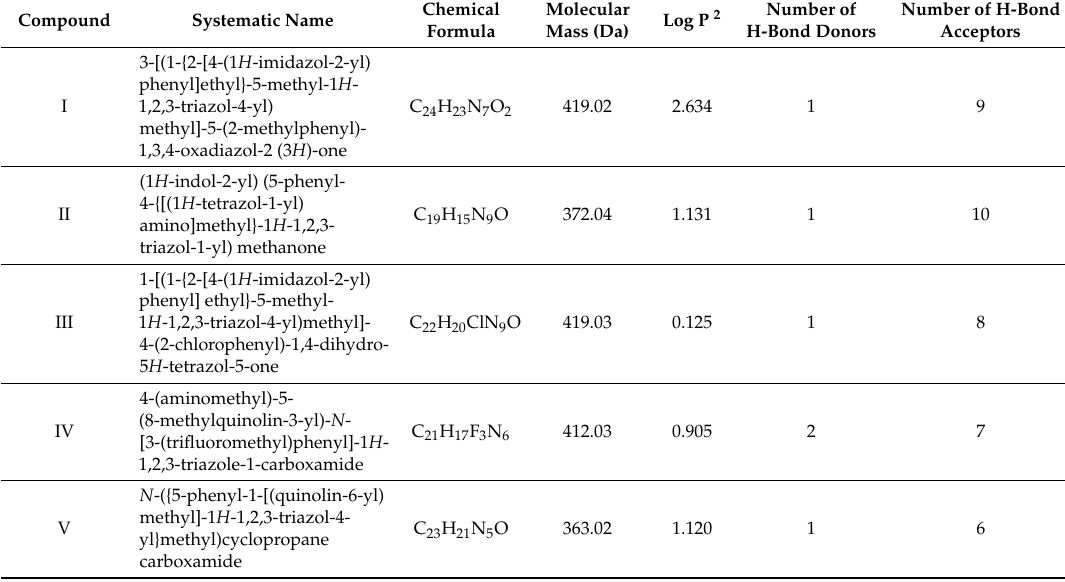
Table 1. CD4-mimetic candidates and their physicochemical parameters associated with the Lipinski’s “rule of five” 1